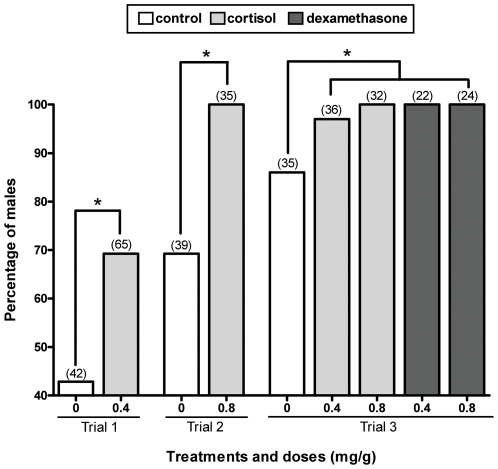
Percentage of males in groups treated with cortisol and the synthetic glucocorticoid receptor (GR) agonist Dexamethasone.All groups were reared at an intermediate temperature (24°C) during the trials. Groups treated with cortisol and Dexamethasone had increased proportions of males compared to the respective controls. Numbers within parenthesis indicate the sample number; asterisks indicate statistically significant differences between groups in the same trial (χ2; P≤0.05; GraphPad Prism v.4.00).